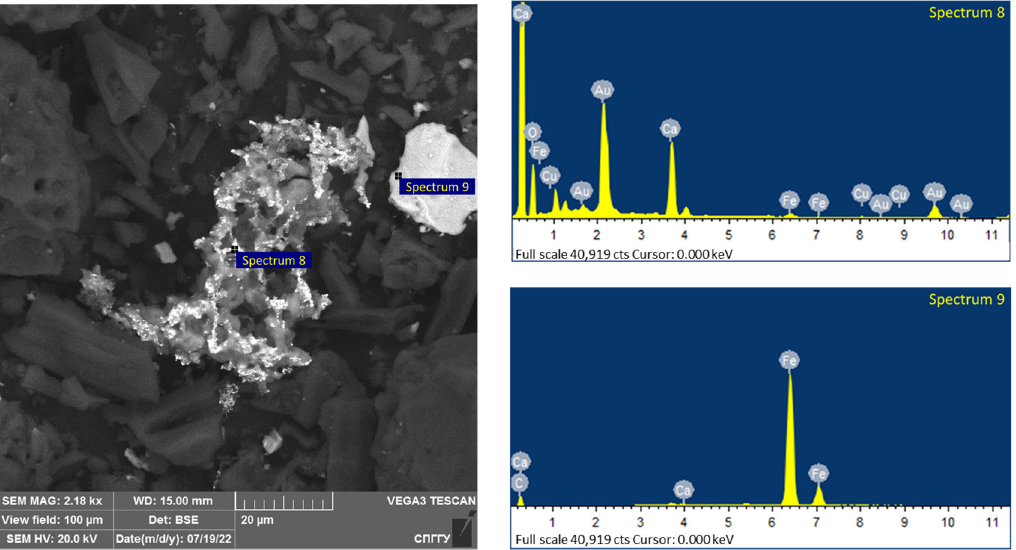
Figure 19. Results of the investigation of samples after microwave treatment with the addition of 10% magnetite.